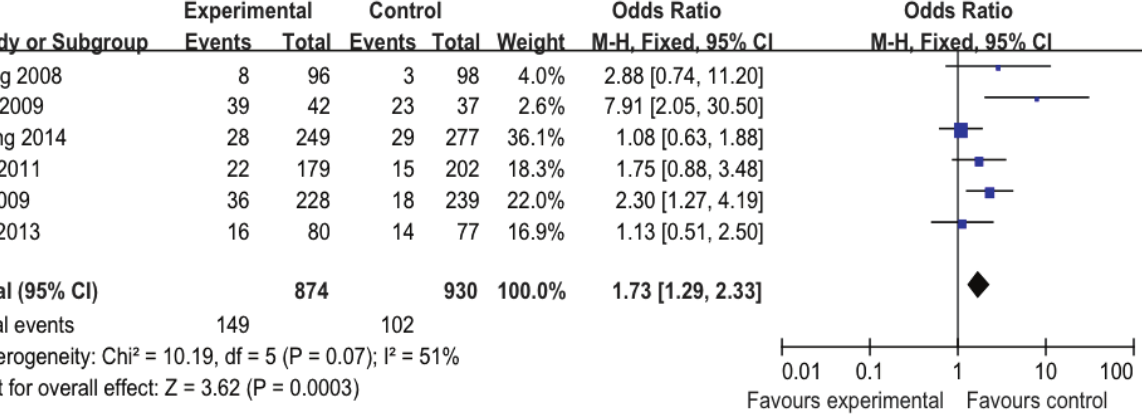
4.3.3 GG vs (GT+TT) The statistical heterogeneity was significant in GG vs (GT+TT) genetic model. The data was pooled by random effect model with OR=1.78, 95%CI:1.35-2.35, p<0.0001. The pooled results indicated that GG genotype increased the risk of developing ischemic stroke compared to GT or TT genotype.